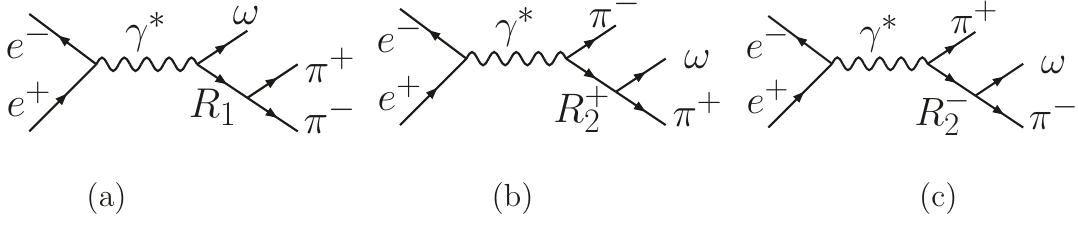
Figure 1 . Feynman diagrams of the quasi-two body processes for e + e − → ωπ + π − .